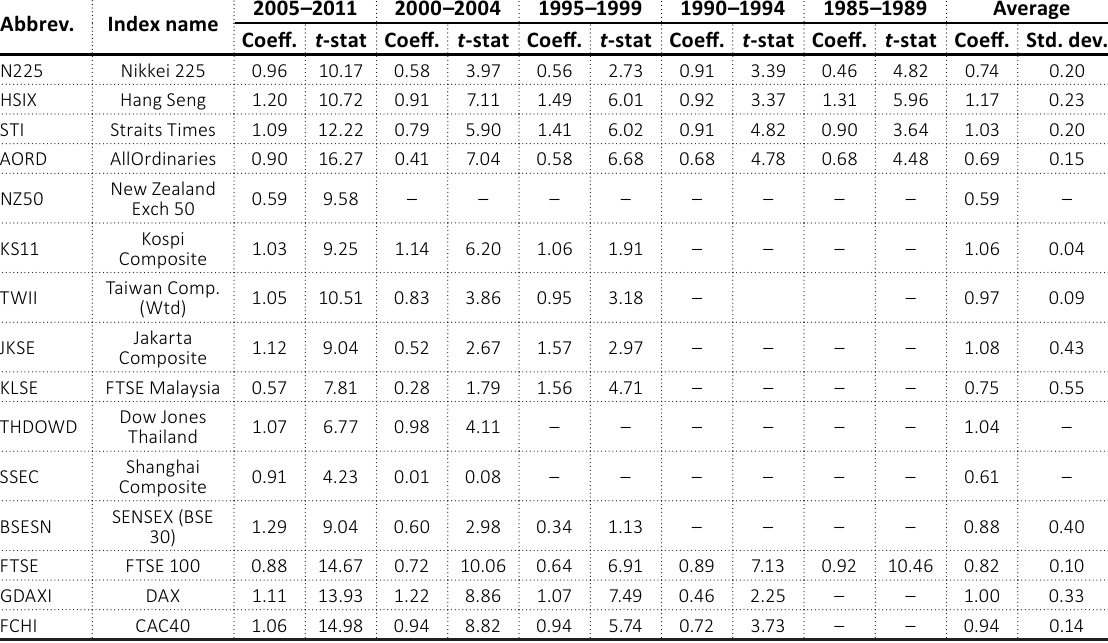
Table 2. Beta estimates for regressing the foreign index monthly returns (based on month-beg. prices) on the S&P 500 index monthly returns (based on month-end prices) [e.g., Nikkei 225 = f (S&P 500)] using all S&P 500 monthly returns*